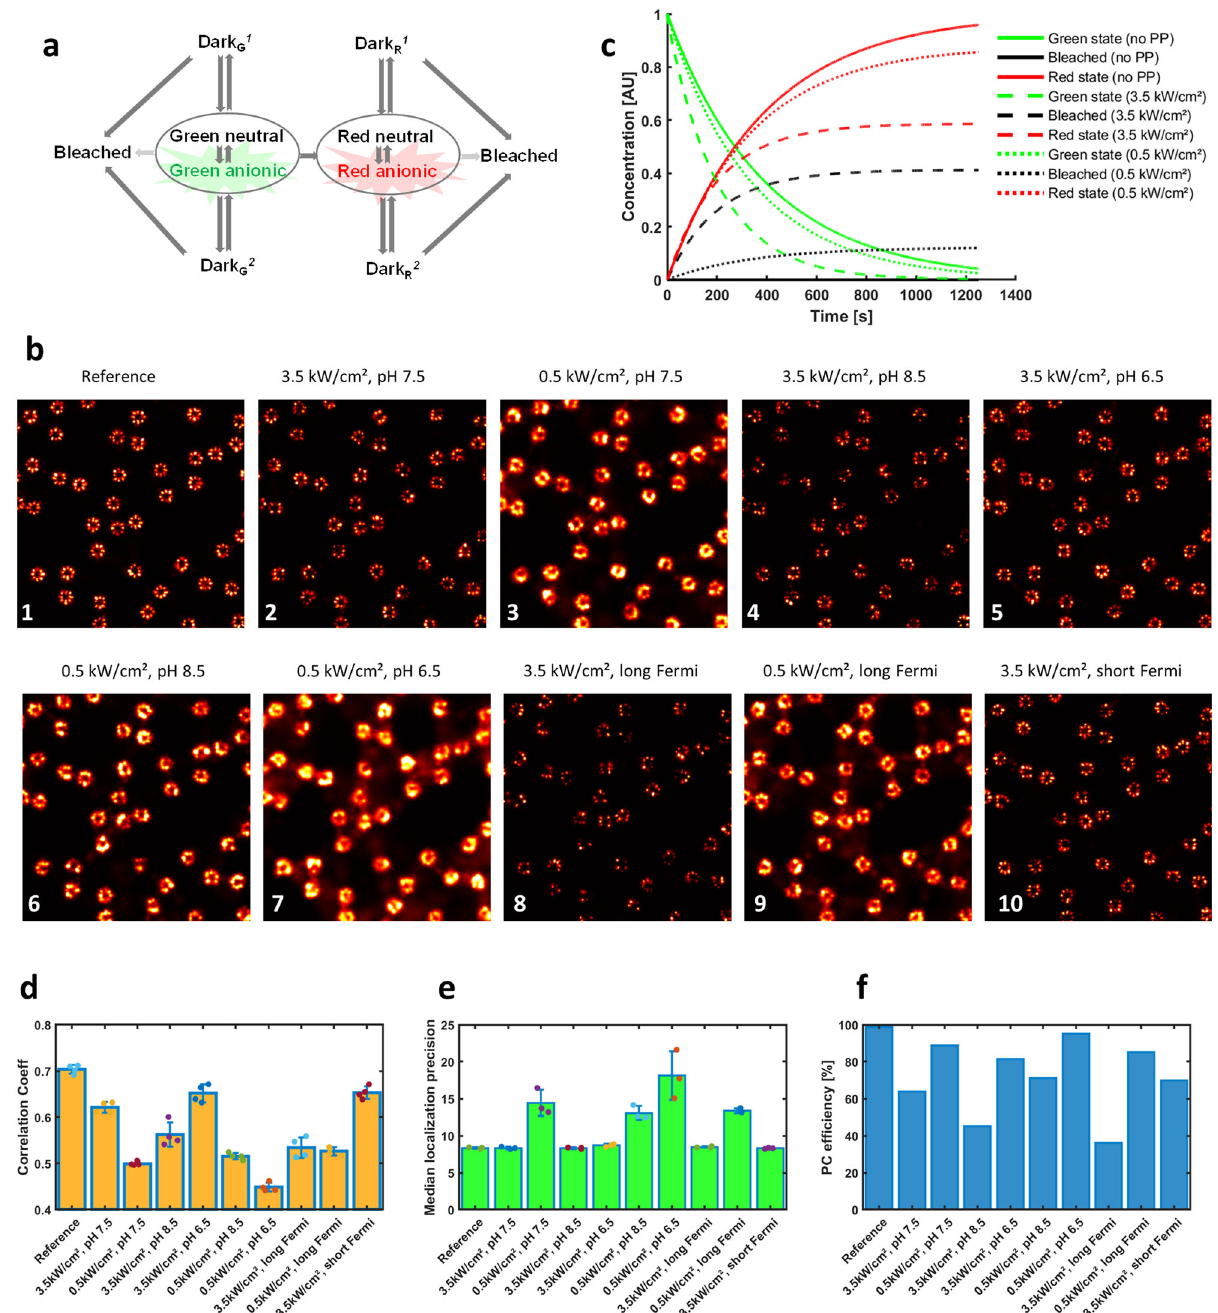
Fig. 1 PALM SMIS simulations of mEos4b-labeled Nup96 in the Nuclear Pore Complex. a Employed photophysical model of mEos4b. For both green and red mEos4b, the fl uorescent state (anionic chromophore) is in rapid equilibrium with a non fl uorescent state (neutral chromophore). Each colored state can transition to two reversible dark states and one nonreversible bleached state. Dark states may also transition to bleached states. b Rendered NPC images (normalized Gaussian) obtained upon processing of SMIS-generated data in various scenarios. pH = 7.5 unless indicated otherwise. Detailed parameters are given in Supplementary Table S2. Green-state photophysics is not considered in the simulation of Panel 1, shown as a reference case. c Predicted green- to-red photoconversion ef fi ciency and green-state photobleaching as a function of readout laser intensity. The decay of the green-state population and the rise of the red-state and bleached populations are shown in green, red and black, respectively. Curves are shown when green-state photophysics (PP) is neglected (plain lines), or when it is considered with 3.5 kW/cm² (dashed lines) or 0.5 kW/cm² (dotted lines) readout laser power density, respectively. d Correlation coef fi cients between rendered images and a ground-truth NPC image with 100% labeling ef fi ciency. e Median merged localization precision retrieved upon processing the SMIS-generated image stacks. Error bars were computed by randomly splitting the dataset in n = 3 subsets and calculating standard deviations between the subsets. Colored dots show individual data points. f Ground-truth photoconversion ef fi ciency.